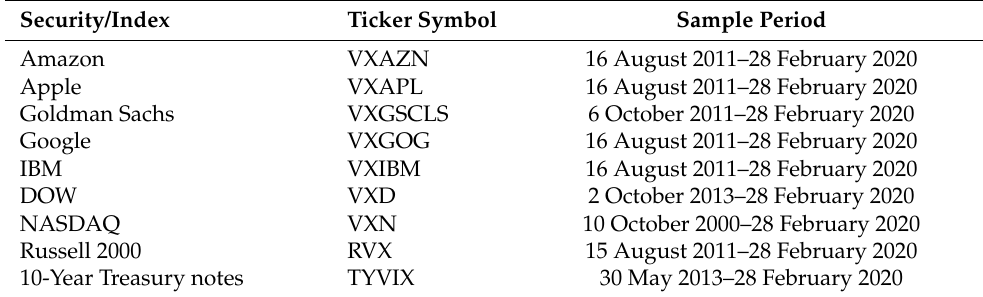
Table 1. Volatility indices—general